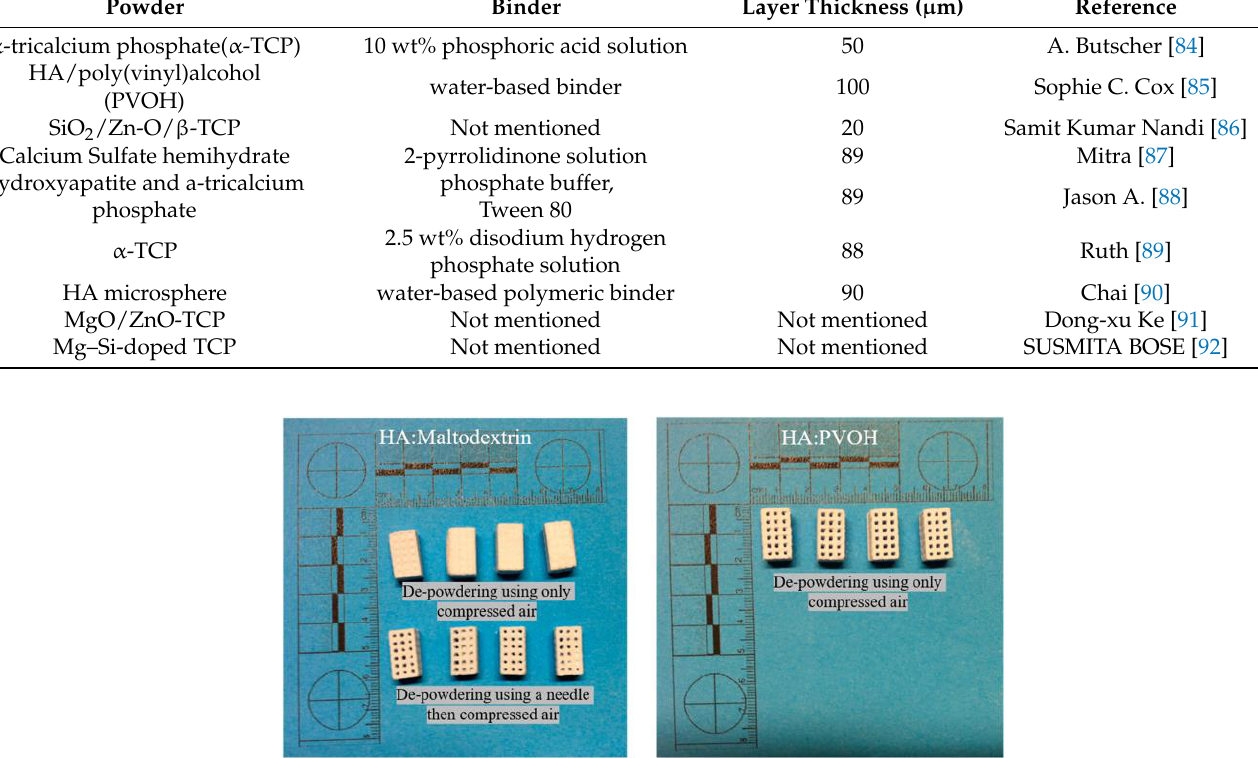
Figure 13. Processing behavior of HA powders mixed with maltodextrin, PVOH (low MW), and PVOH (high MW). After de-powdering, the difference in removing powders from the 3D-printed scaffolds between HA: maltodextrin and HA: PVOH was demonstrated [79].